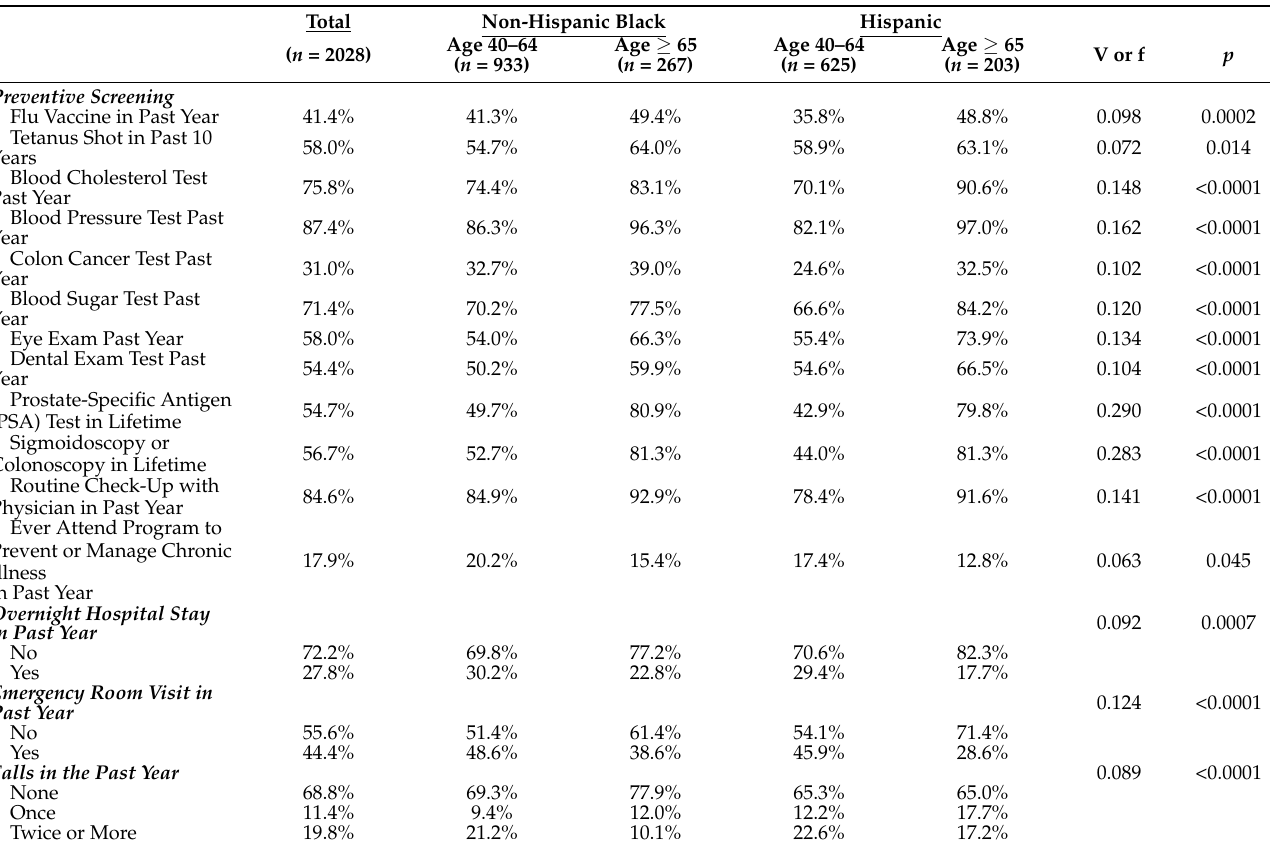
Table 3. Patient context: Healthcare utilization by race/ethnicity and age